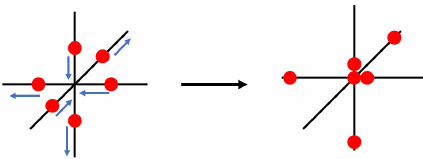
Figure 5: Qubit degrees of freedom originally living on the edges of the cubic lattice are regrouped onto the vertices, such that three qubits are grouped onto each vertex for a single X-Cube